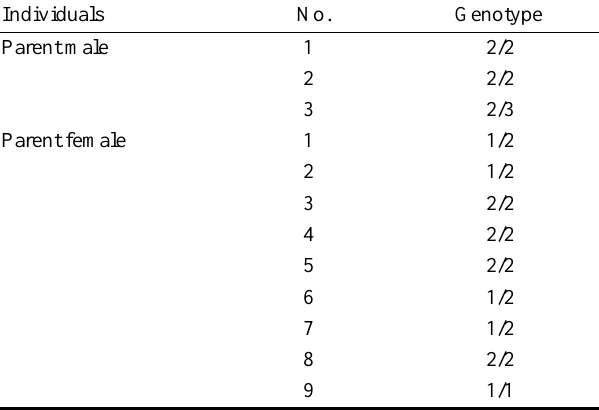
Table 2. Genotypes of parent individuals of the F 2